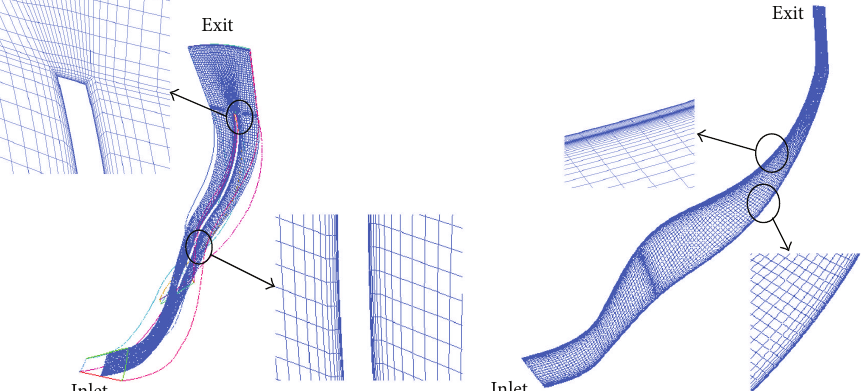
Figure 7: Computational grid for baseline impeller.